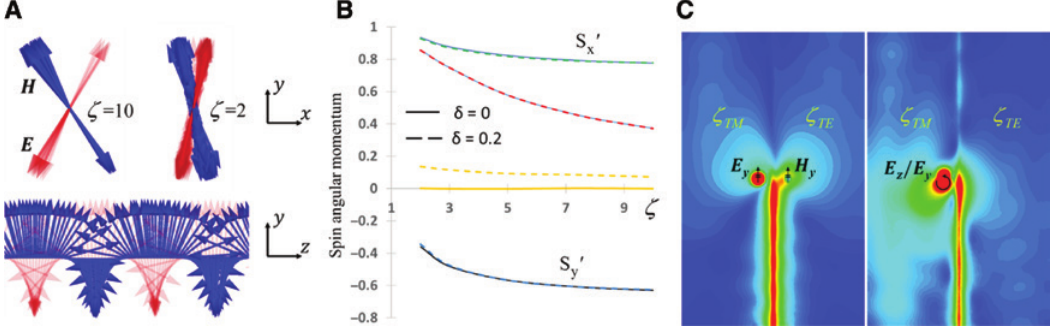
Figure 6: Spin angular momentum properties of line wave. (A) Snapshot in time of electric and magnetic field vectors of LW along the propagation axes with a cross-section view (top) and longitudinal section view (bottom), (B) magnitude of spin angular momentum (red) and normalized contributions of the spin components along different directions of the LW as a function of ζ with and without loss, and (C) E-field magnitude distribution over the surface showing directional excitation of LW via a CP electric dipole (left) and a pair of linearly polarized, in-phase electric and magnetic dipoles (right) on opposite sides of the line